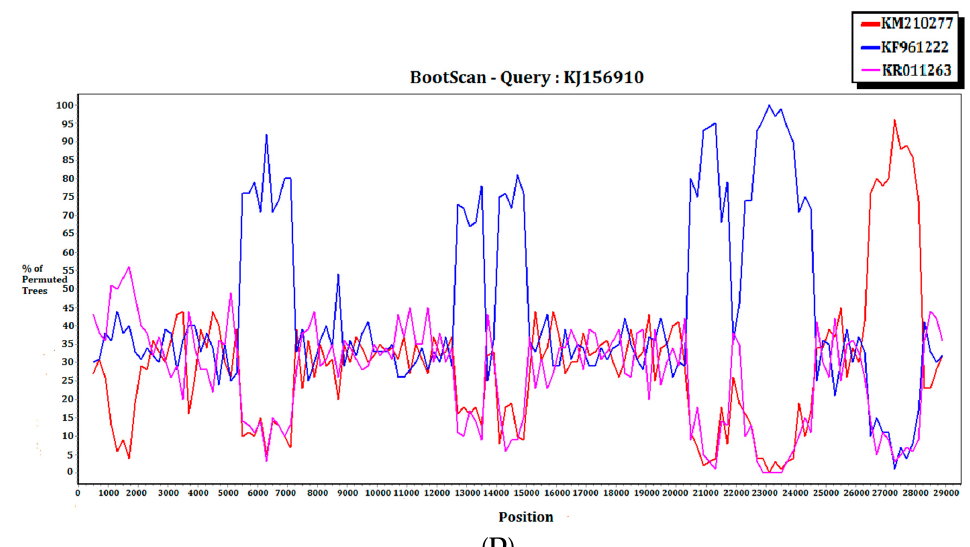
Figure 5. Detection of potential recombination events by bootscan analysis. Bootscanning was conducted with Simplot version 3.5.1 (F84 model; window size, 1000 bp; step, 200 bp). ( A ) KT368830 was used as the query sequence and compared with the genome sequences of a lineage B5 MERS-CoV strain (red, KT368875), a lineage B3 MERS-CoV (blue, KT368860), and a lineage B1 MERS-CoV strain (purple, KJ650926); ( B ) KT368887 was used as the query sequence and compared with the genome sequences of a lineage B3 MERS-CoV strain (red, KT368878), a lineage B4 MERS-CoV strain (blue, KT368890), and a lineage B1 MERS-CoV strain (purple, KP209313); ( C ) KT368869 was used as the query sequence and compared with the genome sequences of a lineage B4 MERS-CoV strain (red, KJ156934), a lineage B3 MERS-CoV (blue, KT368829), and a lineage A1 MERS-CoV strain (purple, JX869059); ( D ) KJ156910 was used as the query sequence and compared with the genome sequences of a lineage B2 MERS-CoV strain (red, KM210277), a lineage B4 MERS-CoV (blue, KF961222), and a lineage B5 MERS-CoV strain (purple, KR011263).